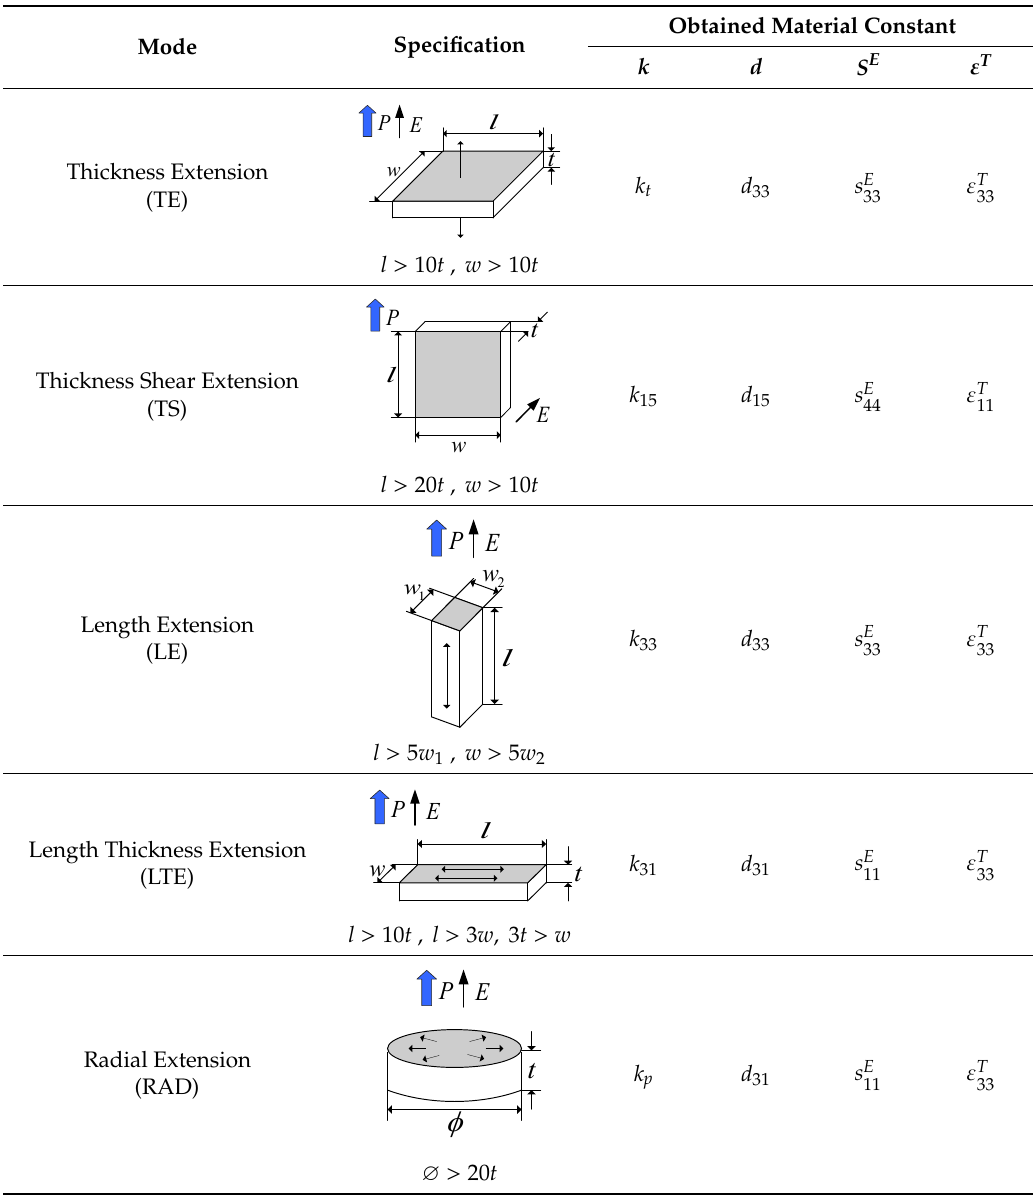
Table 1. Specification on vibration modes of standard piezoelectric elements and their correspondent measured material constants [14].